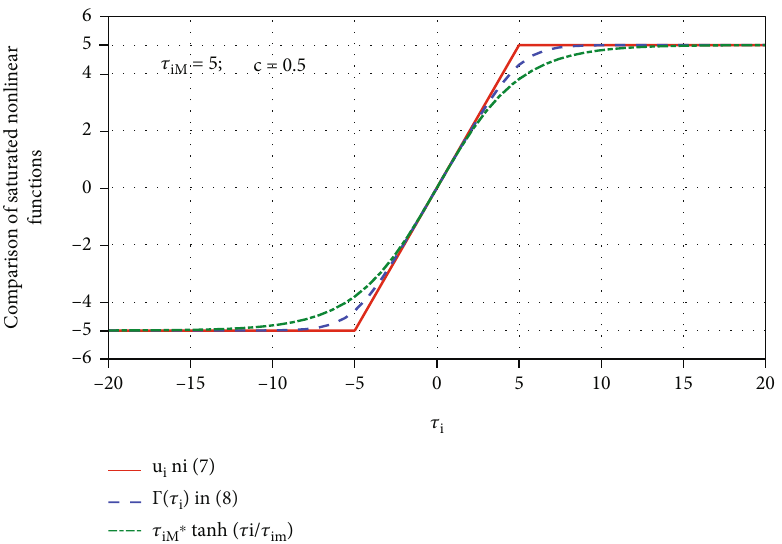
Figure 2: Comparison of saturated nonlinear